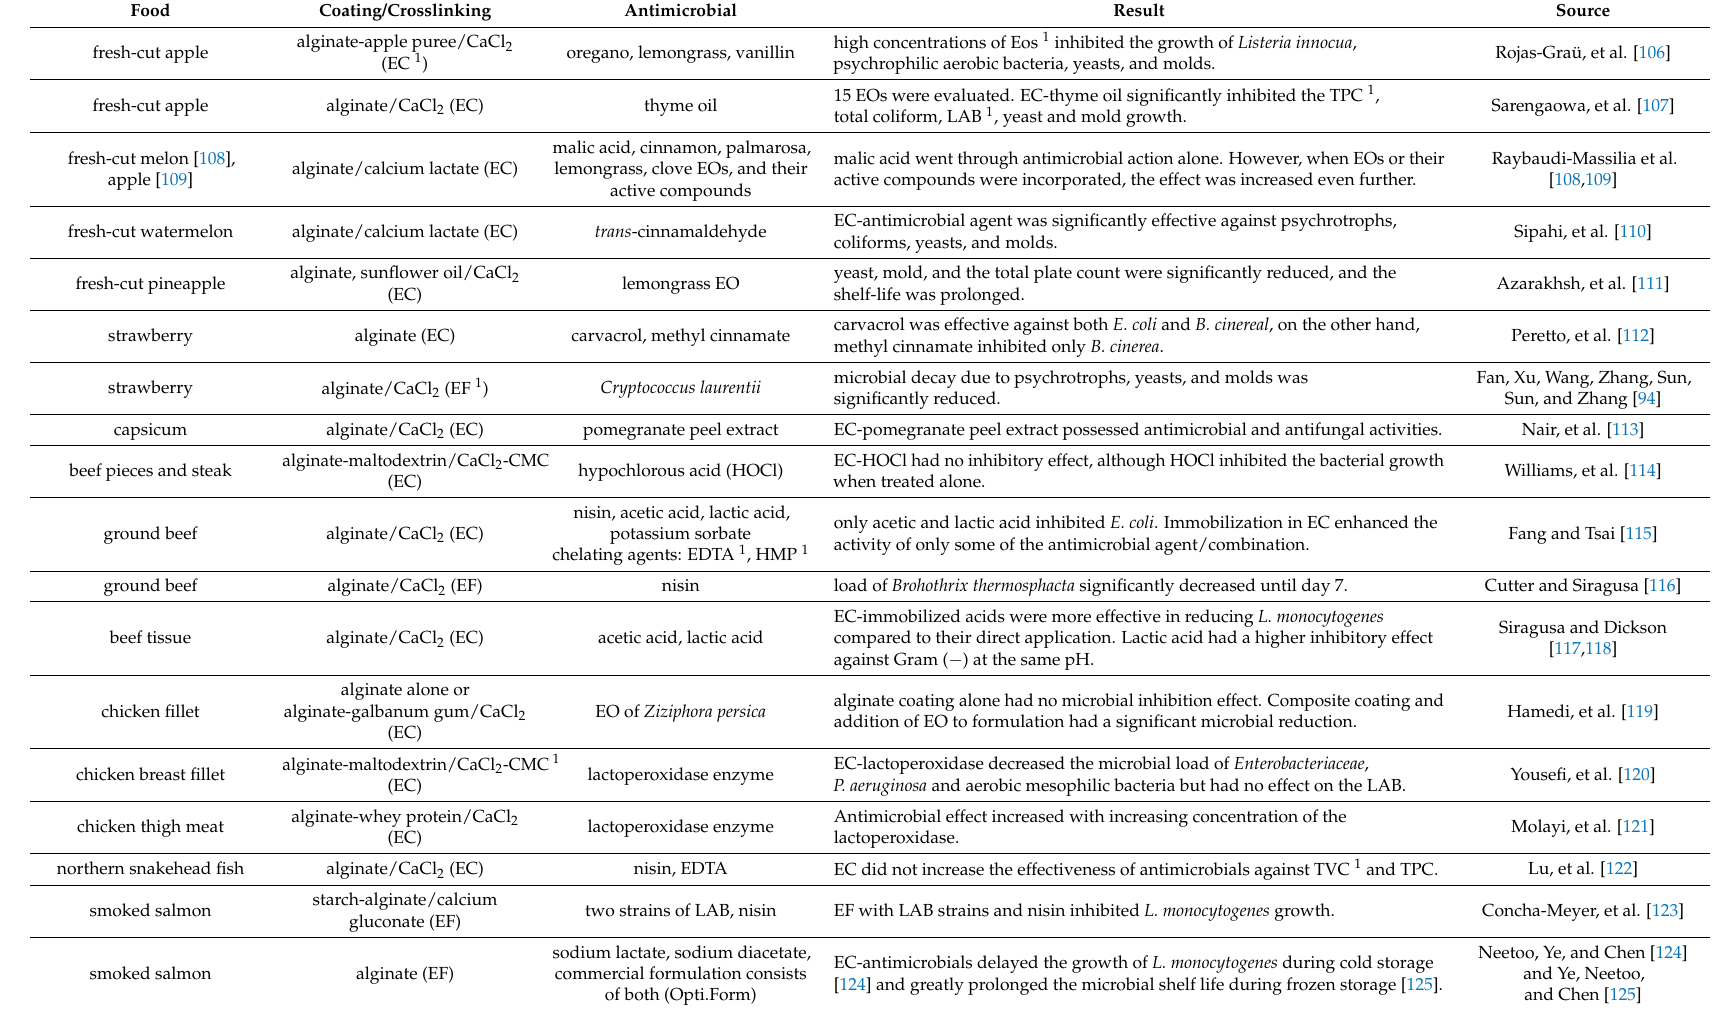
Table 1. The incorporation of antimicrobials in alginate-based edible films and